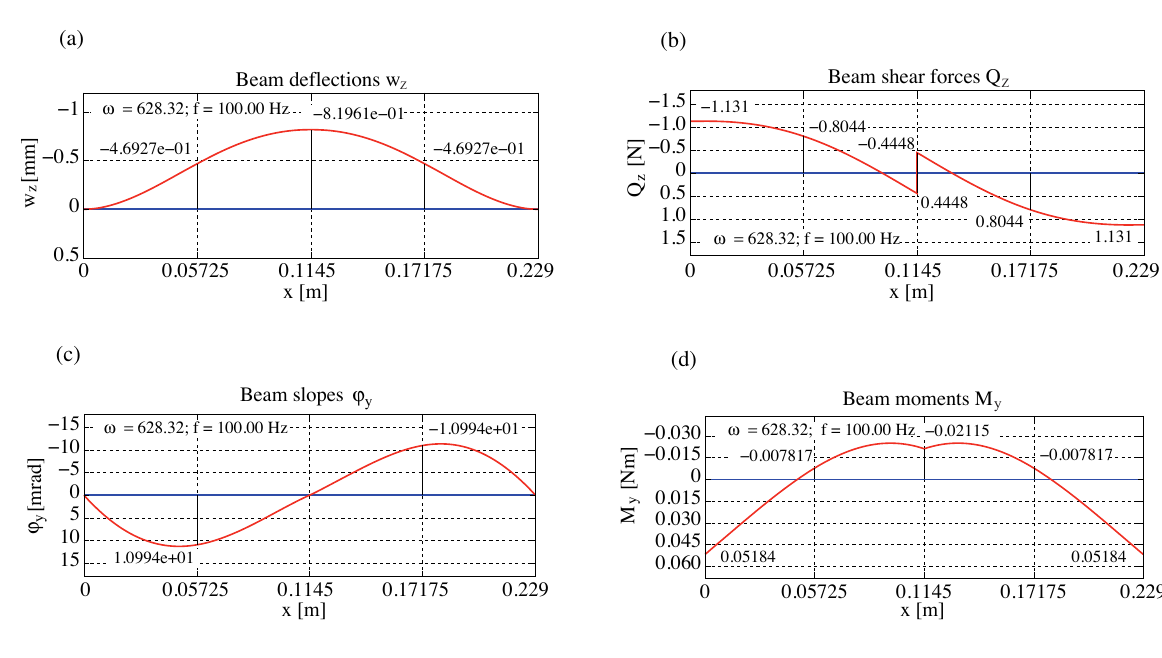
Fig. 14. Amplitudes of displacements and forces at 100 Hz frequency.